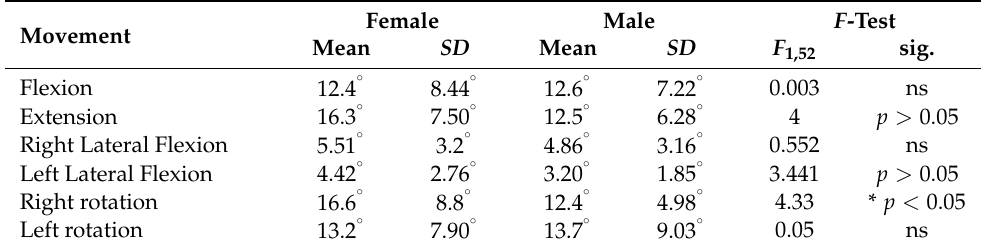
Figure 7. Maximum ROM achieved (in degrees) by sex for each direction of the cervical area. Table 3. Summary in terms of mean and standard deviation of the maximum ROM achieved by sex for each direction of movement. Results of the F -Tests performed: value of the F Statistic and significance (* p < 0.05).